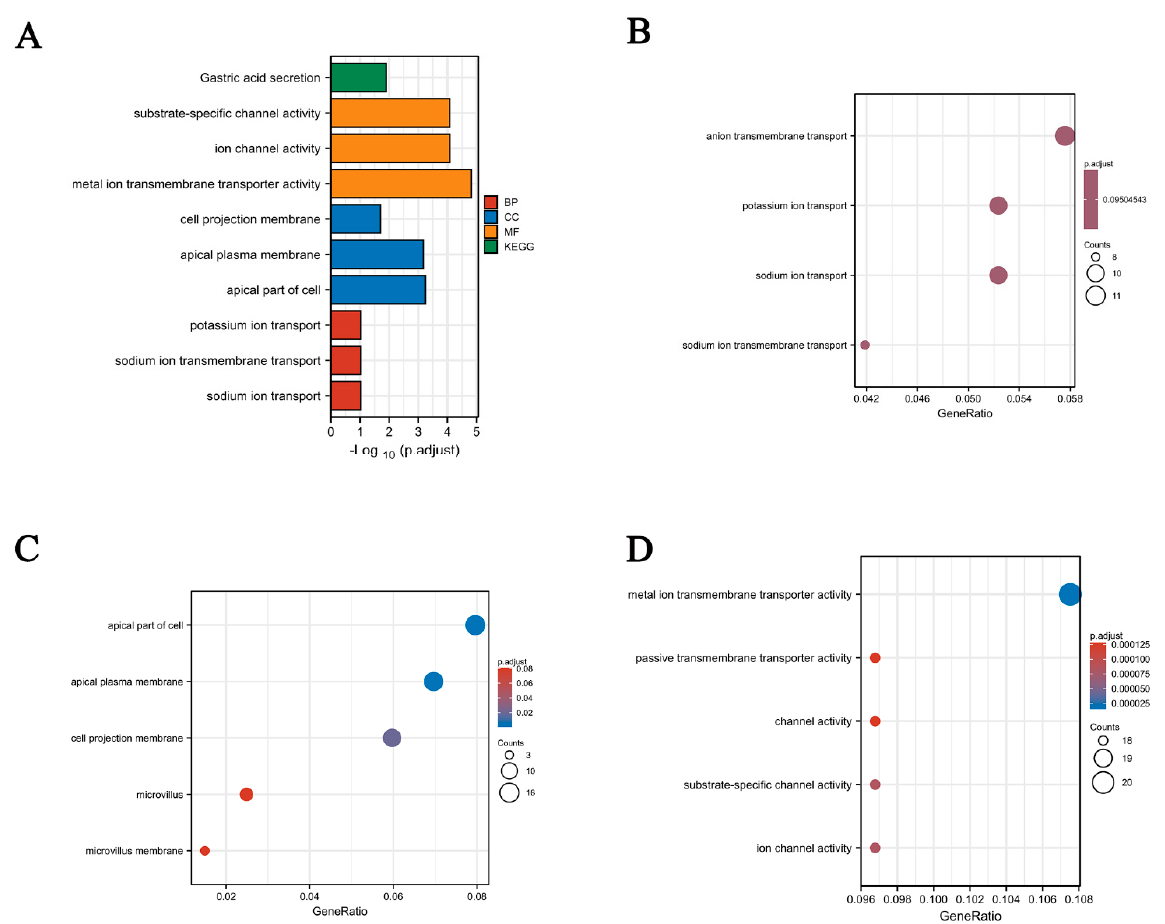
12 Figure 5. ROC curve for diagnostic value of POGK expression in patients with hepatocellular carci- noma. ( A ) in tumor tissue; ( B ) T1 and T2 stage; ( C ) T3 and T4 stage; ( D ) M0 stage; ( E ) N0 stage; ( F ) pathologic stage 1 and 2; ( G ) pathologic stage 3 and 4; ( H ) histologic grade 1 and 2; ( I ) histologic grade 3 and 4. 3.6. Functional Enrichment and Analyses of POGK Gene in HCC by GO Analysis GO enrichment analysis was subsequently conducted to identify the biological pro-